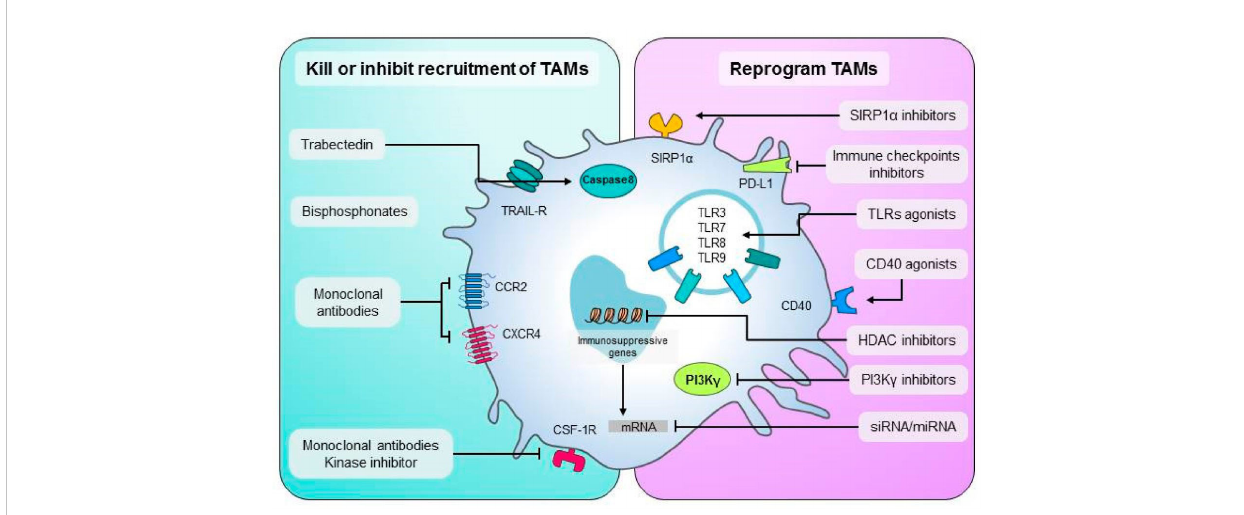
FIGURE 3 An overview of TAMs-targeting treatment approaches. Left are methods to destroy macrophages or prevent their recruitment in malignancies. To recruit additional macrophages to the tumor, monoclonal or kinase inhibitors disrupt the CSF-1/CSF-1R, CCL2-CCR2, or CXCL12/CXCR4 axis. Methods to convert TAMs into anti-tumor M1 effectors are shown on the right. TAM activation is achieved through the use of CD40 monoclonal agonist antibodies or Toll-like receptor agonists. TAMs can be targeted by SIRP1 a inhibitors and immune checkpoint ligand mAbs like PD-L1. this fi gure was reproduced under common creative license (104).